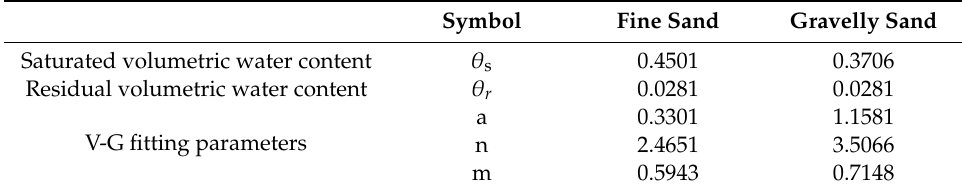
Figure 2. Soil-water characteristic curve (SWCC) fitted to the Van Genuchten (V-G) equation for ( a ) fine sand and ( b ) gravelly sand. Table 2. Van Genuchten equation fitting parameters of soils.